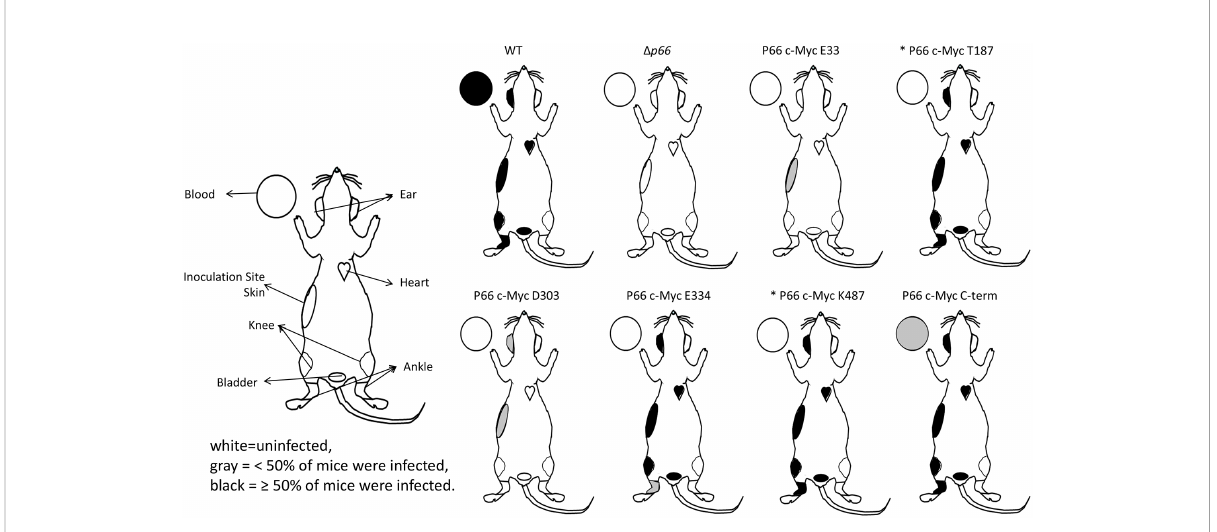
FIGURE 8 Infectivity and dissemination of B31 A3 c-Myc P66 cc mutants. Groups of 5 mice were inoculated with WT and mutant strains of B. burgdorferi . Two clones per c-Myc P66 mutant were included (10 mice per mutant). At 28 days post-infection, mice were euthanized and tissues were harvested. Tissues were used to inoculate BSKII medium and these cultures were monitored for spirochete growth for up to 8 weeks. Diagrams show the tissues included in the study and their culture positivity data. White = uninfected, gray = <50% of mice were infected, black = ≥ 50% of mice were infected. * = cultures were monitored for 1